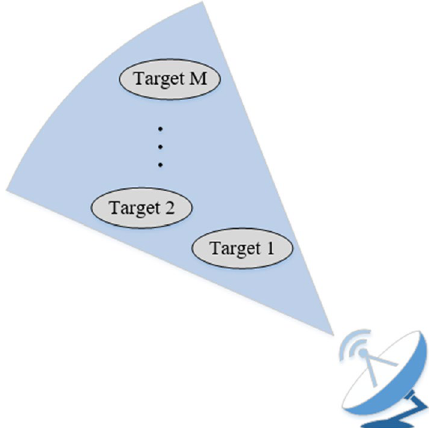
Fig. 2 Multiple targets in the same beam